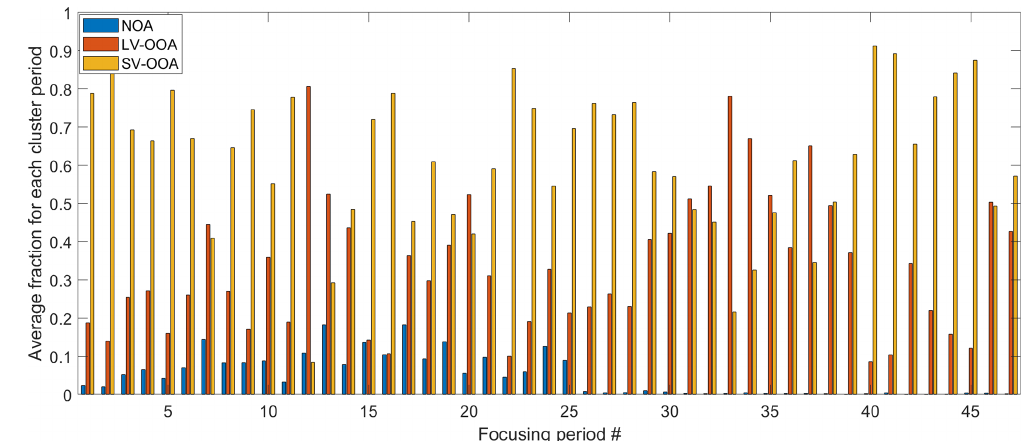
Figure 3. Average mass fraction of each PMF factor for the 47 focus